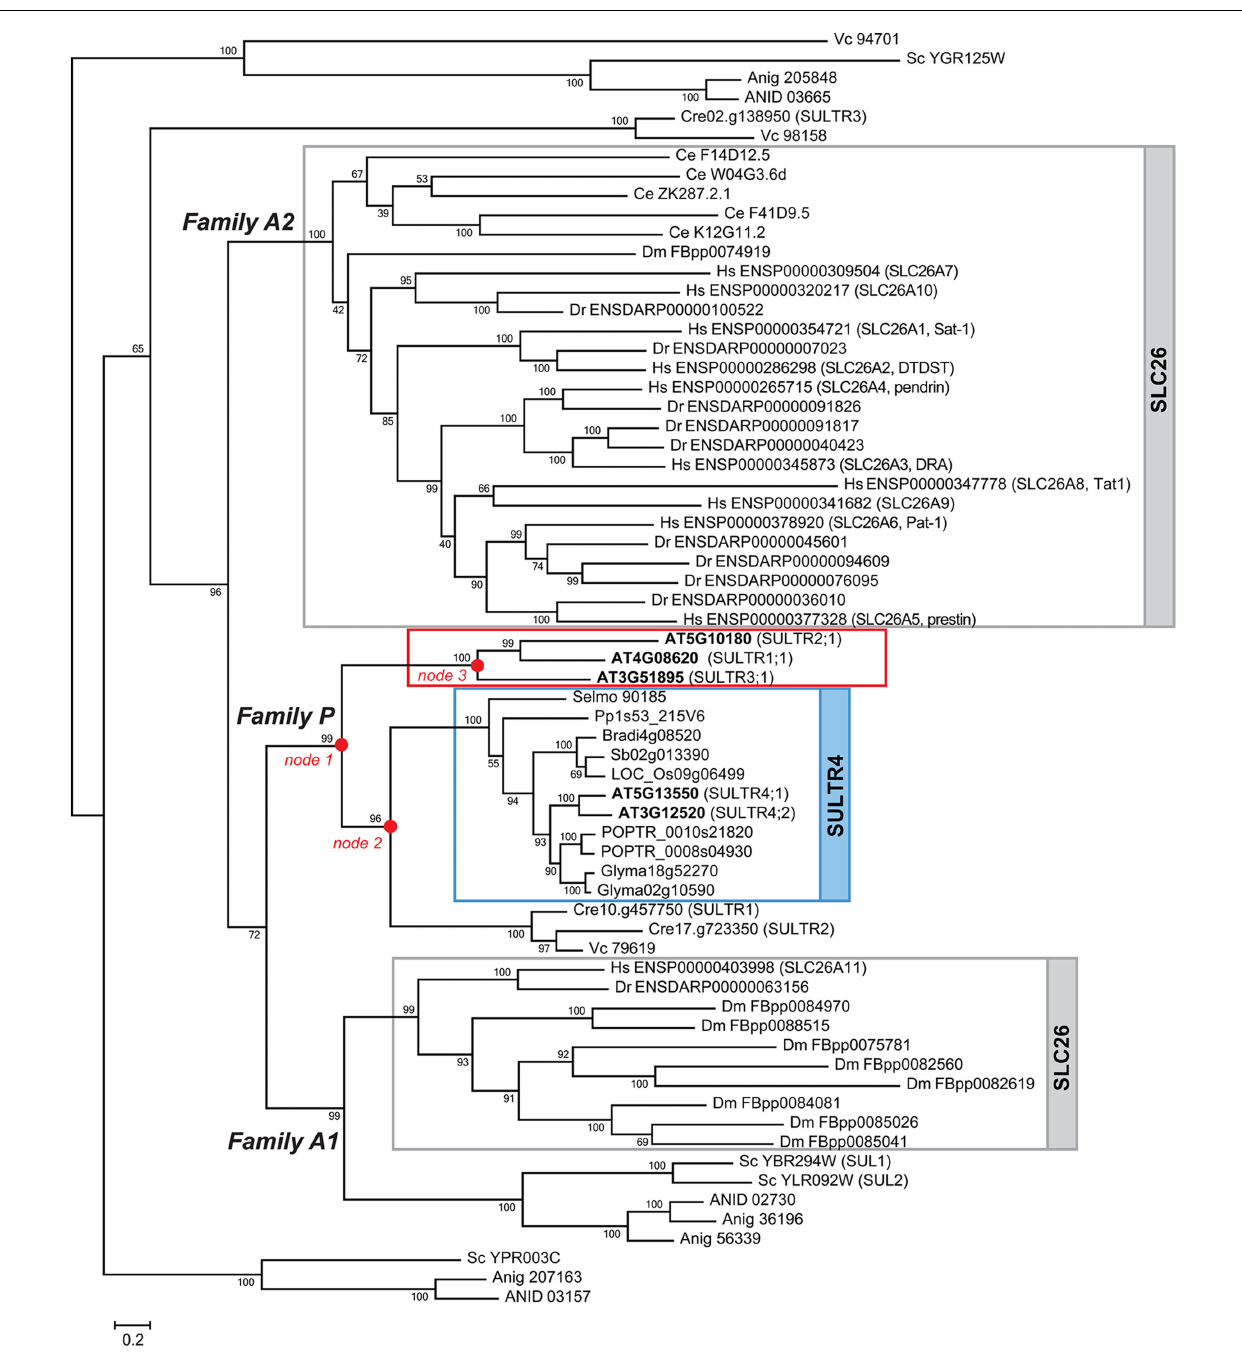
FIGURE 2 | Phylogenetic relationships of SUL, SULTR, and SLC26 in Tribe 1. The lineage that splits to SULTR1, SULTR2, and SULTR3 subfamilies ( Figure 3 ) are boxed in red. SULTR1;1, SULTR2;1, and SULTR3;1 from Arabidopsis were selected as representatives of these subfamilies to construct the phylogenetic tree.The SULTR4 subfamily in plants and SLC26 in animals are highlighted in blue and gray, respectively.The nodes 1–3 where the plant SULTR lineage splits into subfamilies are indicated by red dots.The bootstrap values are shown at the nodes.The locus numbers or gene IDs are indicated according to Ensembl (http://www.ensembl.org), Phytozome (http://www.phytozome.net/), SGD (http://yeastgenome.org/), JGI (http://www.jgi.doe.gov/), and BROAD (http://www.broadinstitute.org).